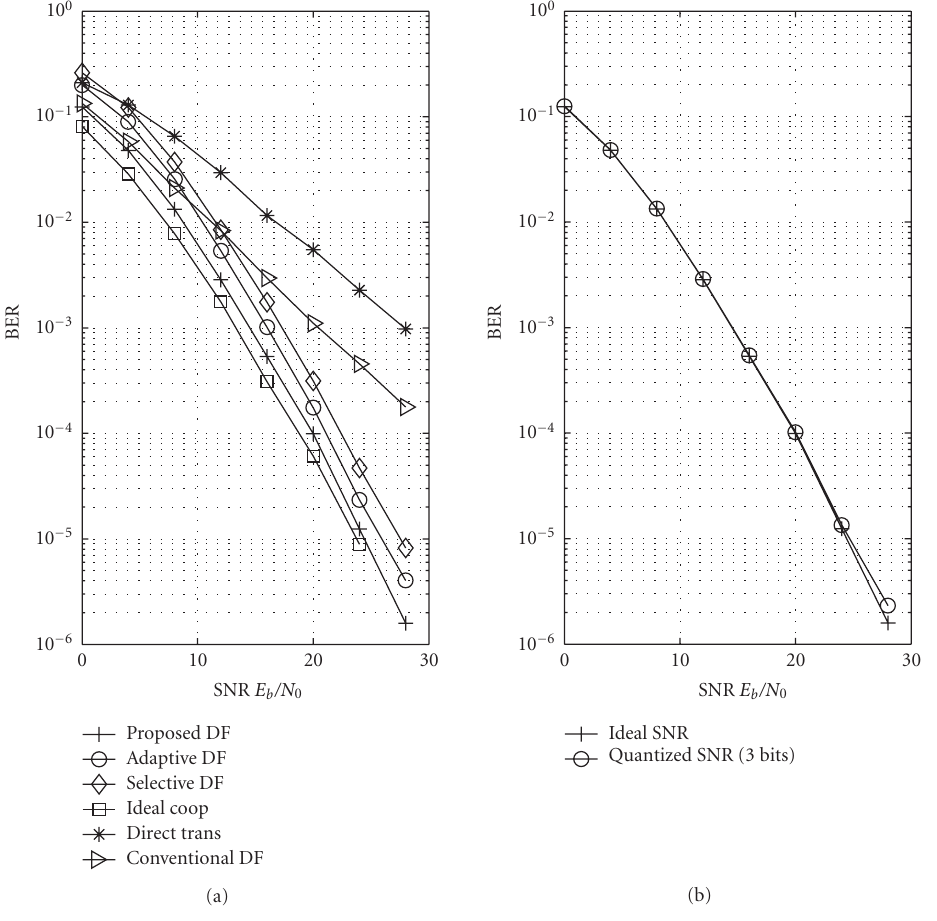
Figure 1: Performance curves ( d SR = 0 . 5, d RD = 0 . 5).